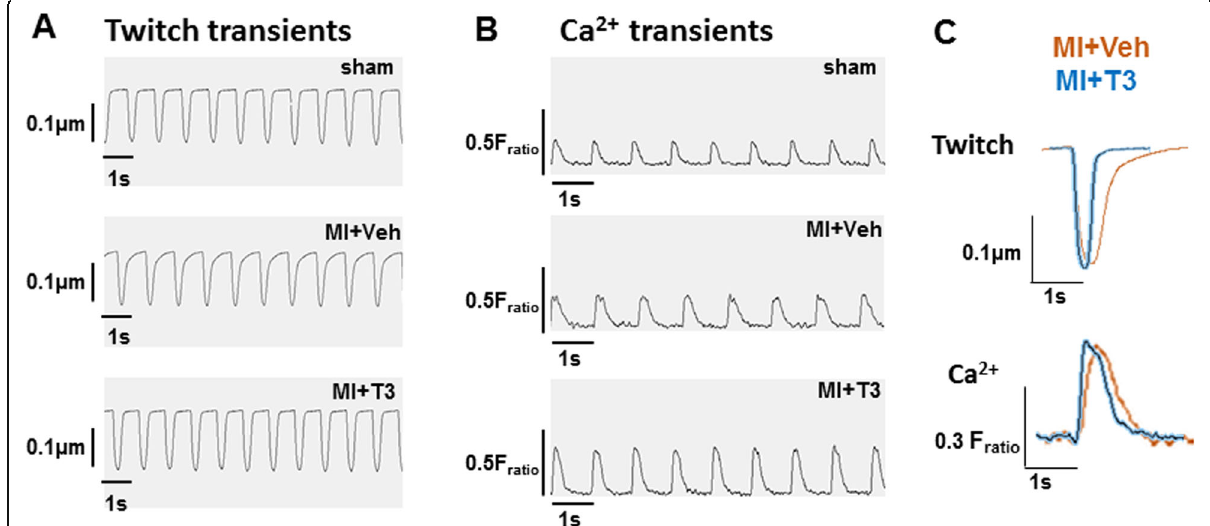
Fig. 3 Recordings of representative calcium and contractile/twitch transients. Simultaneous recordings of calcium and contractile transients of field stimulated (1 Hz) single cardiomyocytes captured by the IonOptix imaging system: a displacement (Twitch) transients over time of representative single cardiomyocytes from sham, MI + Veh and MI + T3 rats. Vertical scale bar = 0.1 um sarcomere length, horizontal scale bar = 1 s; b Ca 2+ transients of single myocytes from each study group showing ratio of fluorescence intensities excited at 340 and 380 nm (F ratio = vertical scale bar); c overlay of twitch and Ca 2+ transients from representative cardiomyocytes isolated from MI + Veh and MI + T3 rats